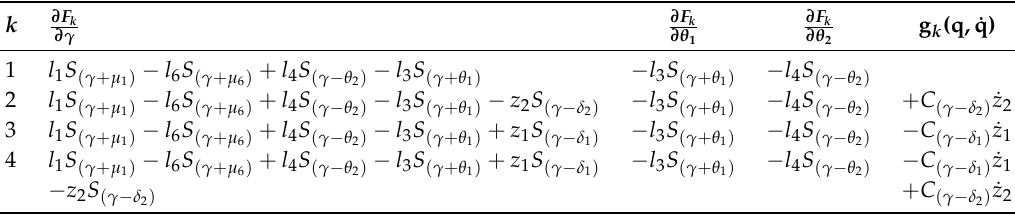
Table 2. Terms of differential equations of the implicit Jacobian for the four configurations (where sin ( · ) ≡ S ( · ) and cos ( · ) ≡ C ( · )